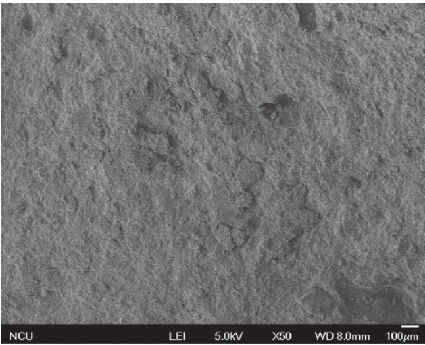
Figure 12: Mesostructure of the laterite after alkaline-solution permeation (pH � 13 and t �